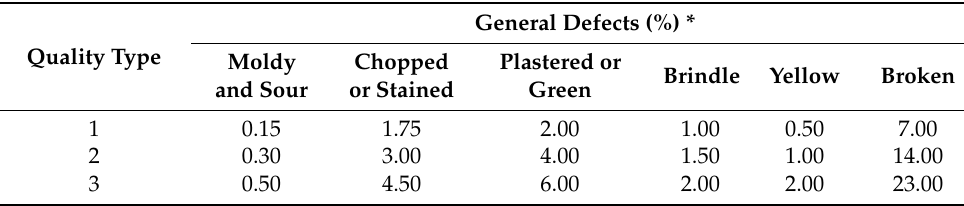
Table 1. Maximum tolerance limits of defects established for classifying polished processed rice according to the commercial quality